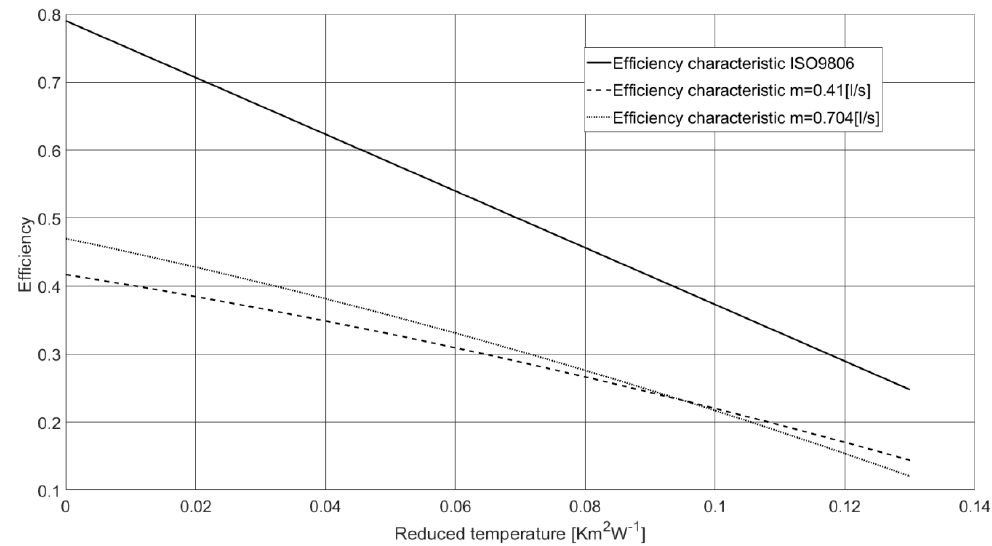
Figure 16. Efficiency characteristics of a battery of 20 collectors heat loaded with a 1000 dm 3 storage tank.